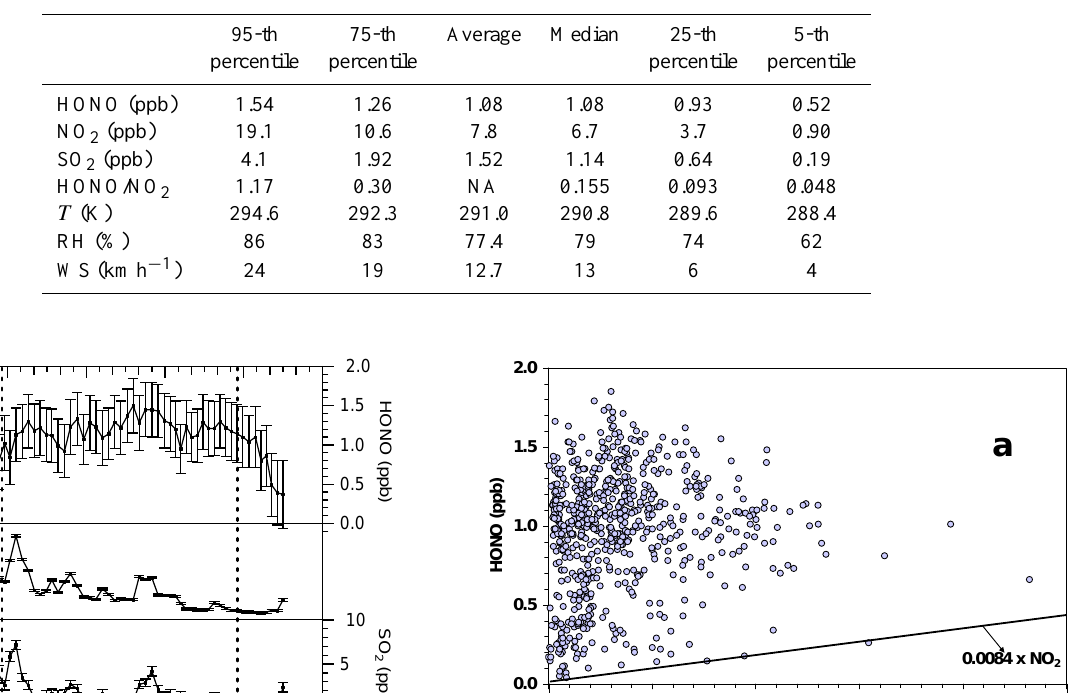
Table 1. Statistical summary of observations during the pseudo steady state period (10:00p.m.–05:00a.m.), 24 July–9 August 2005 (432 observations).